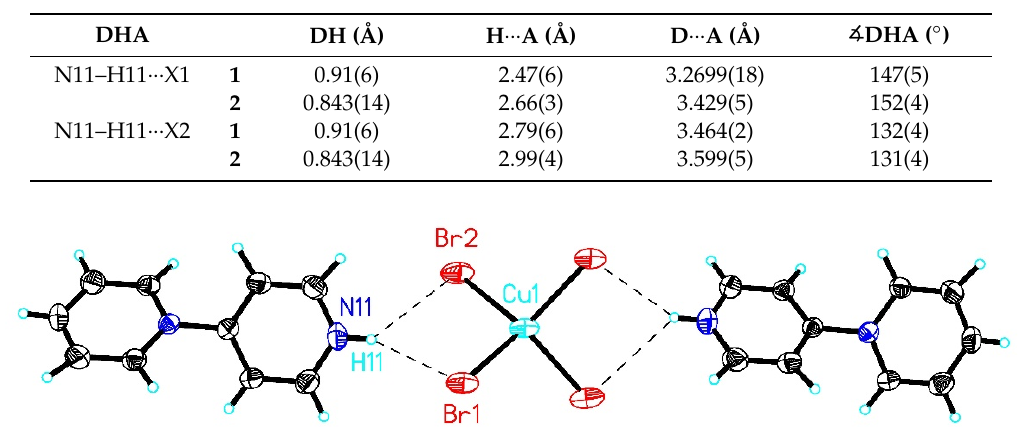
Figure 3. Br···H hydrogen bonding in 2 . See Table 3 for hydrogen bonding data. Figure 2. A superposition of the two disordered positions of the organic dication in 1 . Table 3. Hydrogen bonding parameters in 1 and 2 .